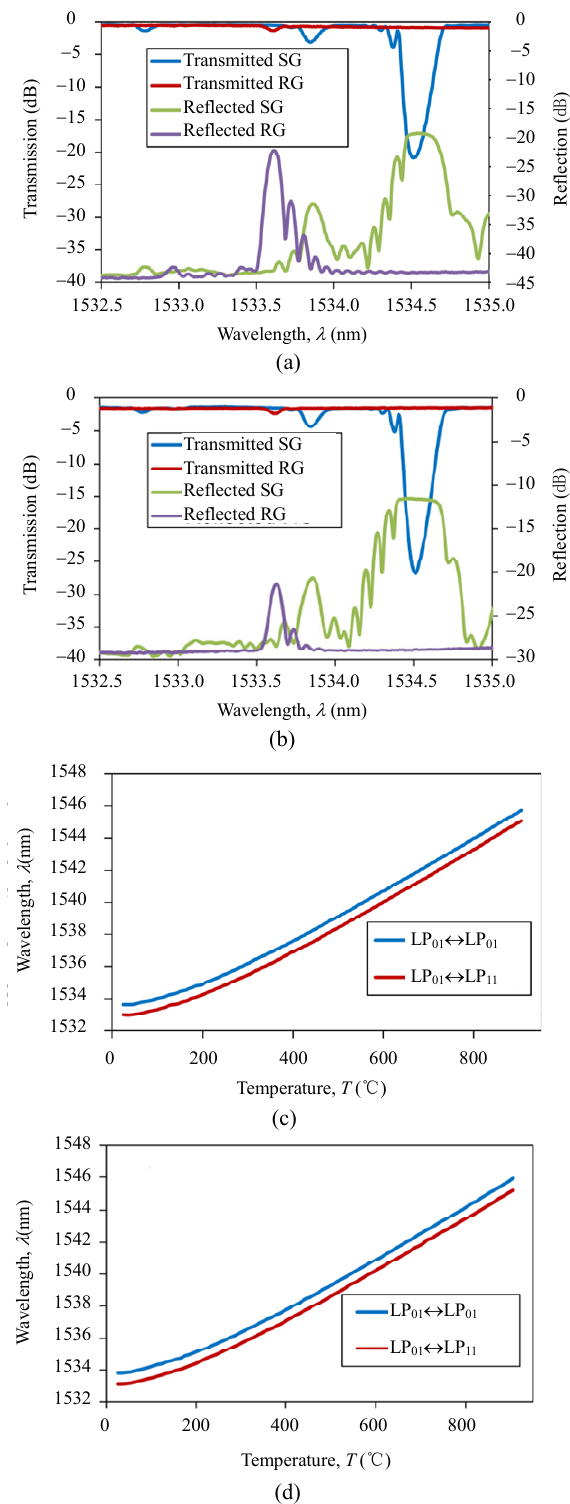
Fig. 4 Transmission and reflection spectra of SG and RG at room temperature of: (a) treated fiber and (b) non-treated fiber. The wavelength response of RG in (c) treated fiber and (d) non-treated fiber with the increasing temperature in the range of 25 ℃ ‒ 900 ℃